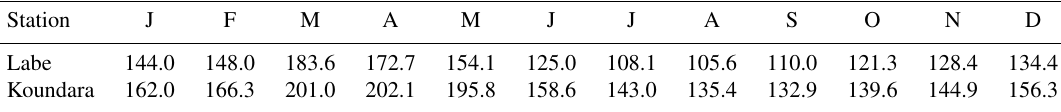
Table 3. Average monthly potential evapotranspiration at Labe and Koundara.